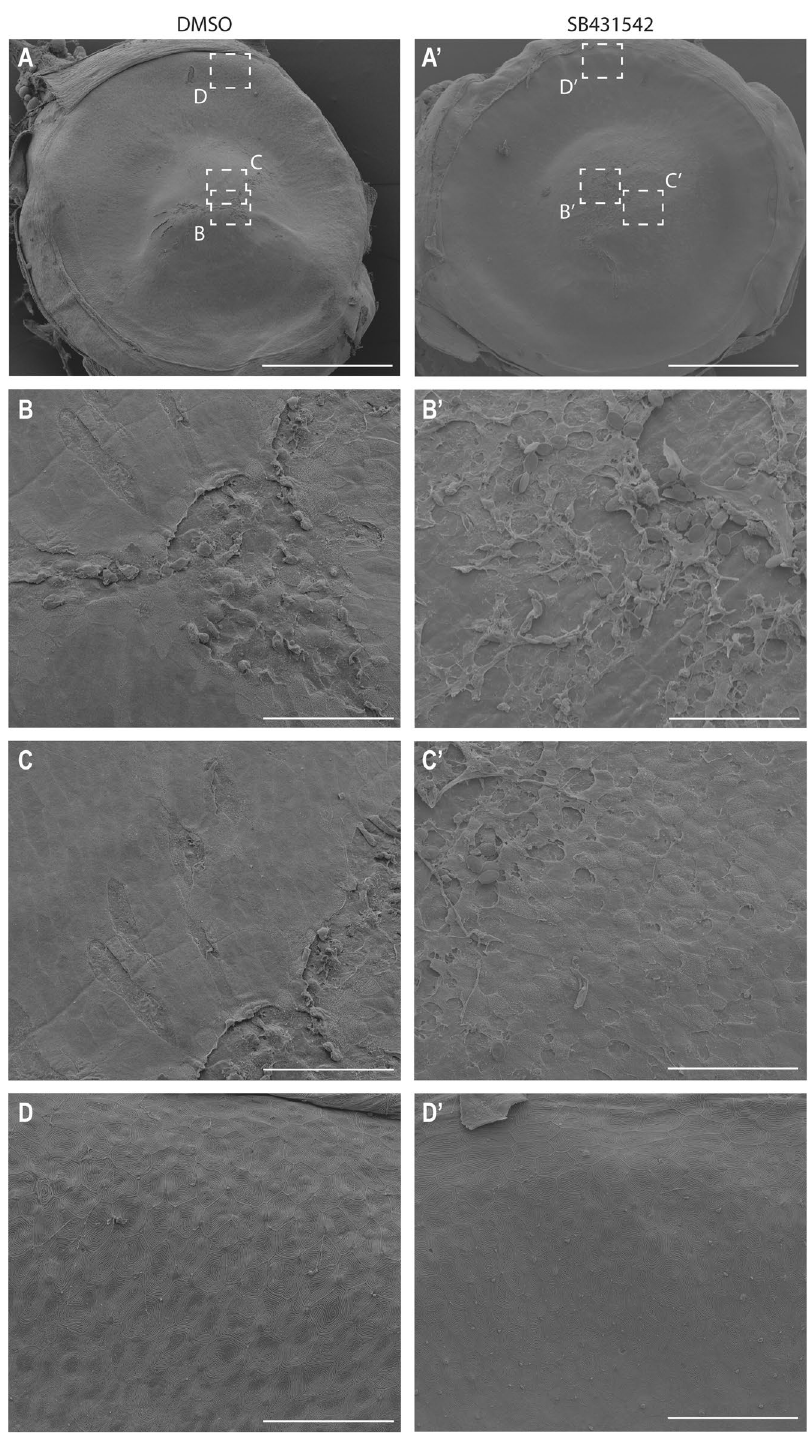
Figure 9. TGF-beta receptor inhibition delays wound closure. SEM images showing the wound site, a site adjacent to the wound site, and peripheral/limbal cornea at 3HPW in DMSO ( A – D ) versus TGF-beta receptor I inhibitor (SB431542, ( A’ – D’ )) -treated fish. ( A , A’ ) Overview of the eye, indicating the locations of areas in ( B – D’ ). ( B , B’ ) The wound site exhibits a greater disorganization under TGF-beta receptor inhibition. ( C , C’ ). While the wound border has a smooth surface in the control, the TGF-beta receptor inhibition leads to a defected surface. ( D , D’ ). In the peripheral region, the TGF-beta receptor inhibition seems to not affect drastically epithelial cells. Scale bars: 500 µm ( A , A’ ), 50 µm ( B , B’ , C , C’ , D , D’ ). HPW: hours